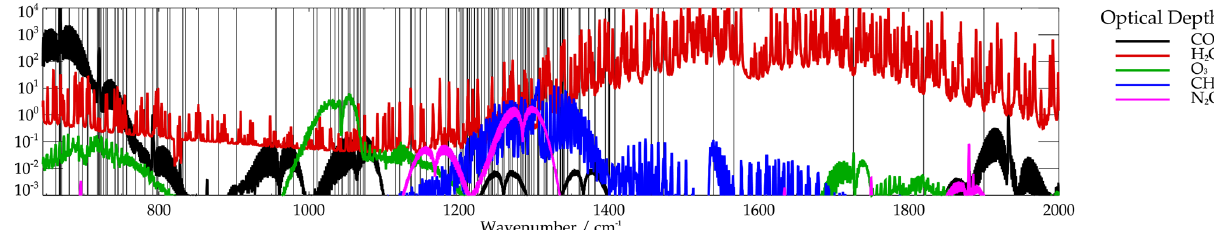
Figure 2. IASI channels used by the IMS scheme (indicated by vertical black lines) and nadir optical depths of major absorbers.